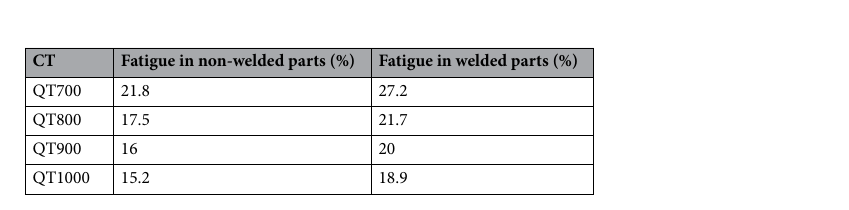
Table 15. Comparison of fatigue damage for different CTs.